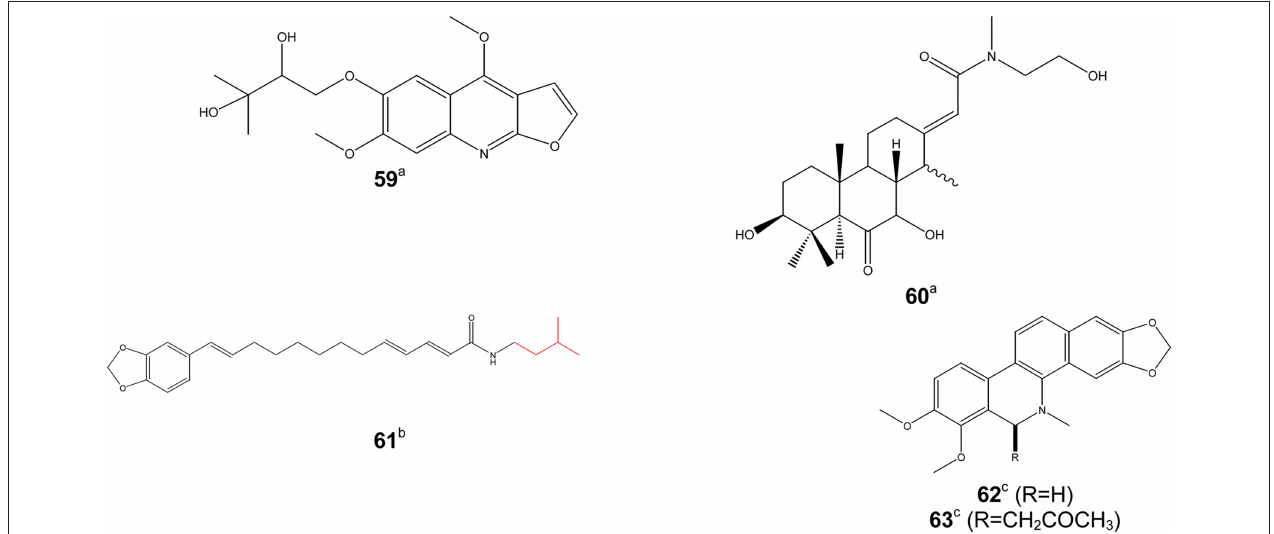
FIgUrE 4 | Bioactive alkaloids. Activity [(a) antimicrobial, (b) antimalarial, (c)